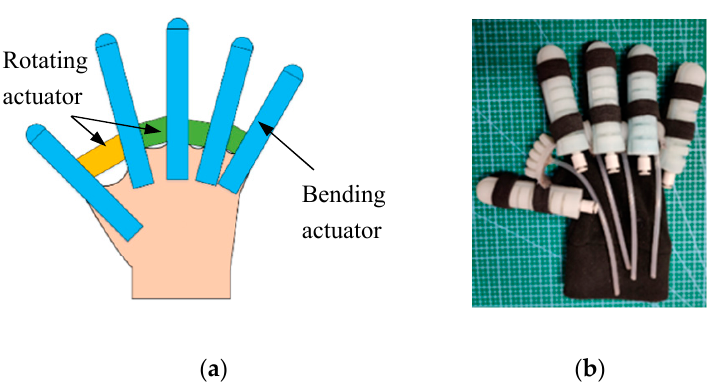
Figure 1. Soft Rehabilitation Gloves. ( a ) Schematic of SRGs and ( b ) Prototype of SRGs. The bending actuator is utilized to realize the flexion and extension motion when inflated or deflated with compressed air. The structure of the bending actuator is shown in Figure 2, which consists of a strain layer with a semicircular cross-section, a restricted layer, and a series of air chambers. When compressed air is filled in the airway, the actuator bends to the restricted layer. The parameter value set for the four-finger bending actuator is listed in Table 1.